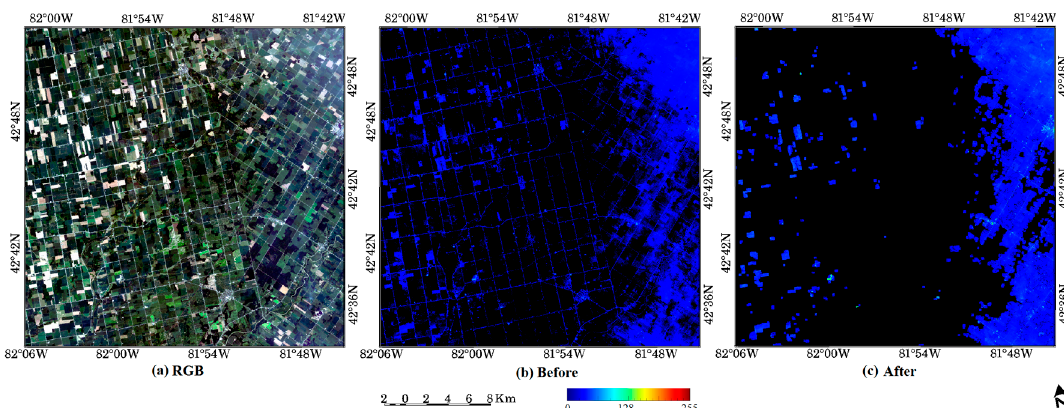
Figure 5. Samples of spurious HOT responses and comparison of HOT images before and after post-processing: ( a ) true color sub-image taken from Landsat-8 OLI scene (Path 19/Row 30) acquired on 26 August 2014 (ID: LC80190302014238LGN00); ( b ) HOT image before post-processing; and ( c ) HOT image after post-processing.